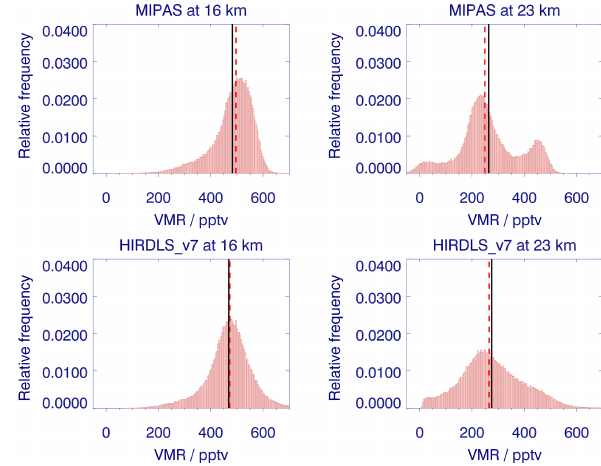
Figure 21. Histogram of collocated MIPAS CFC-12 measurements (top panels) and HIRDLS measurements (bottom panels) for the years of 2005–2008 at 16km (left panels) and 23km (right panels). The black line indicates the location of the mean of the sample, while the red dashed line marks the median.